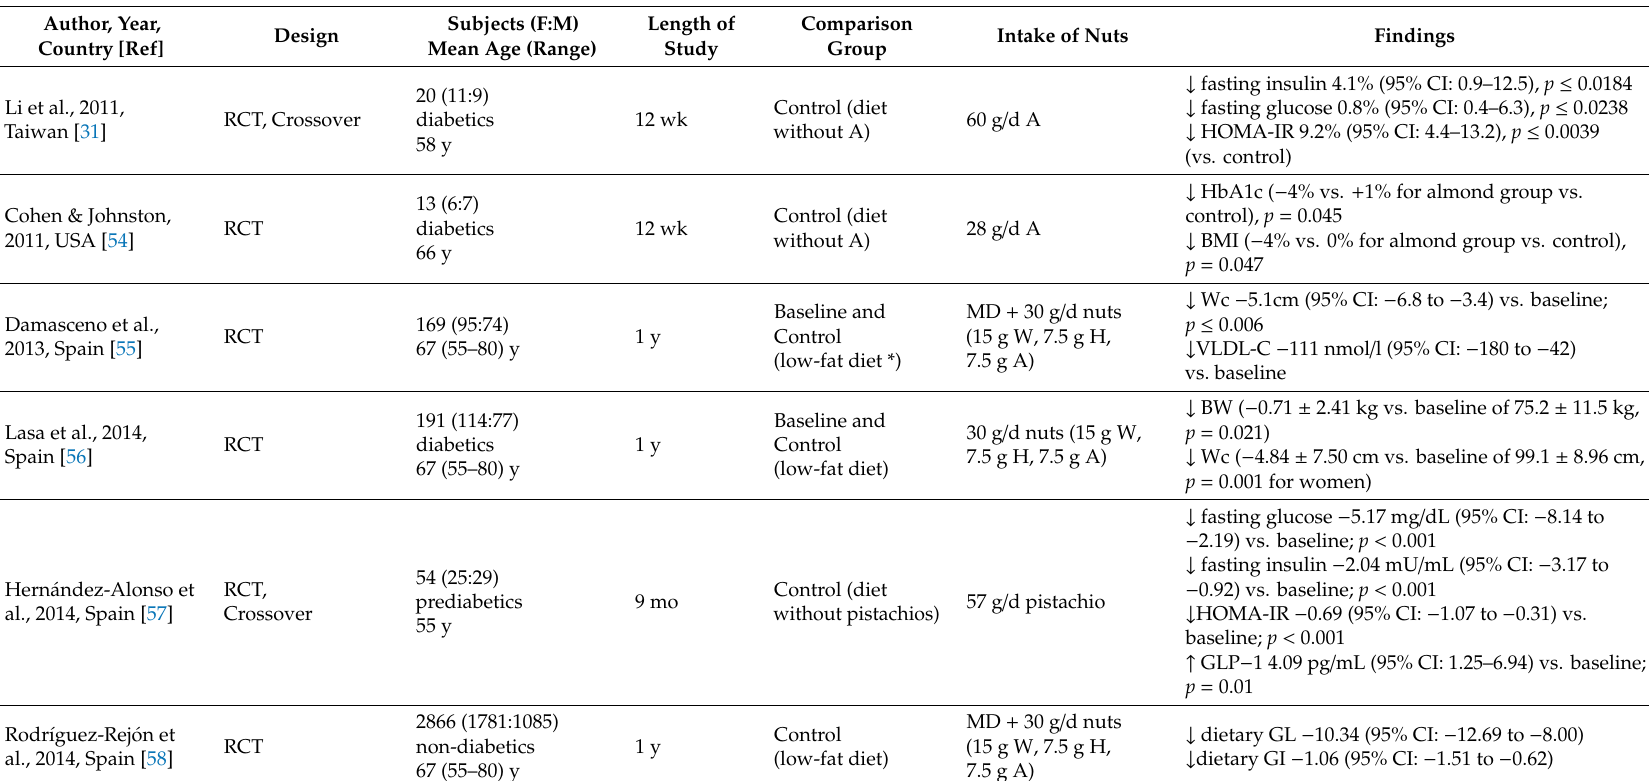
Table 3. Nut consumption and changes in biochemical and anthropometric parameters in intervention